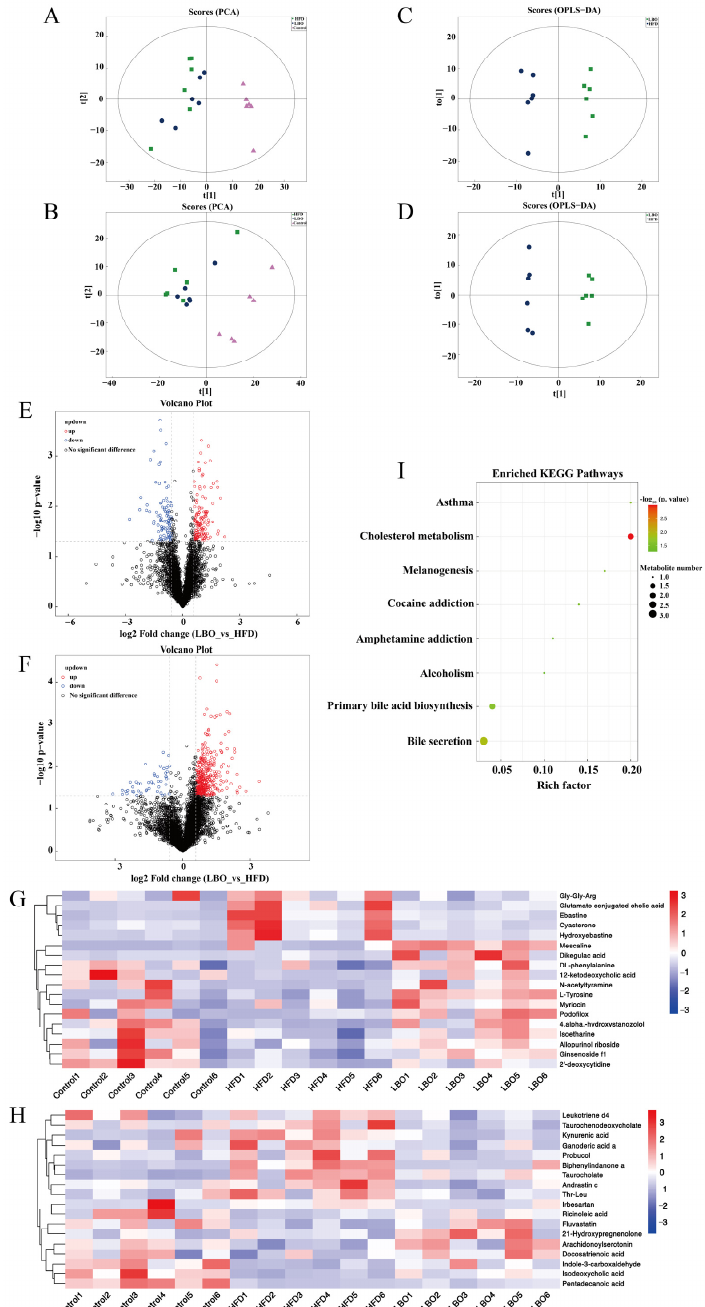
Figure 5. Effect of LBO on fecal metabolites in HFD mice. The PCA scatter diagrams in ( A ) negative and ( B ) positive ion modes. Plots of OPLA-DA scores in ( C ) negative and ( D ) positive ion modes. Significant differences in metabolites between HFD and LBO were indicated by a volcano plot. Differential metabolites in ( E ) negative and ( F ) positive ion modes. The hierarchical clustering heatmap showed ( G ) metabolites with significant differences in the negative ion mode ( VIP > 2 and p < 0.05) and ( H ) metabolites with significant differences in the positive ion mode ( VIP > 1 and p < 0.05). ( I ) Analysis of the KEGG metabolic pathway between HFD and LBO. Each metabolic pathway is represented by a bubble in the diagram. The size of the air bubbles represents the quantity of metabolites. The p value (the negative common logarithm, − log10 p value) of the enrichment analysis is expressed by the color of the bubbles; the darker the color, the lower the p value and the more significantly enriched. LBO: Lycium barbarum oligosaccharide; HFD: high-fat diet; PCA: principal component analysis; VIP : variable importance in the